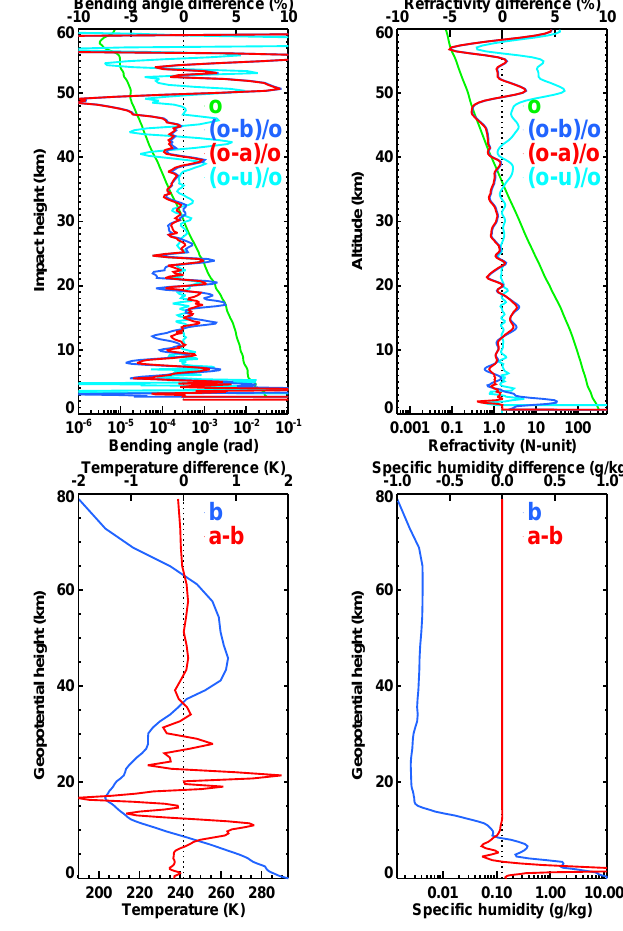
Figure 4. Tropopause heights for the COSMIC occultation of Figs. 2 and 3. Top left: bending angle and its covariance transform. Top right: refractivity and its covariance transform. Bottom left: dry temperature and its lapse rate. Bottom right: background tempera- ture and its lapse rate from colocated and simultaneous ECMWF background.